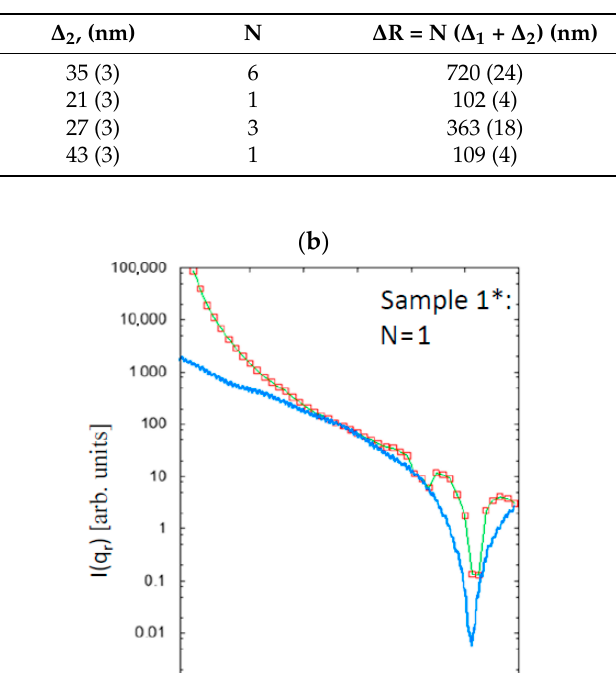
Table 3. Manually obtained equatorial dimensions ∆ 1 and ∆ 2 of the investigated POF samples, number of repeat units N, and thickness of the region of decaying densities ∆ R.